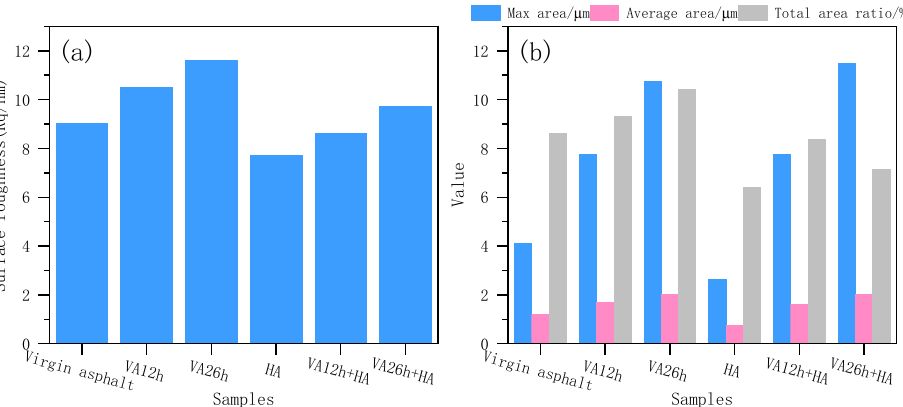
Virgin asphaltVA12h VA26h Figure 8. Results of the microstructure characteristics of asphalt binder samples: ( a ) roughness of AFM surface; ( b ) statistics of bee-like structure.